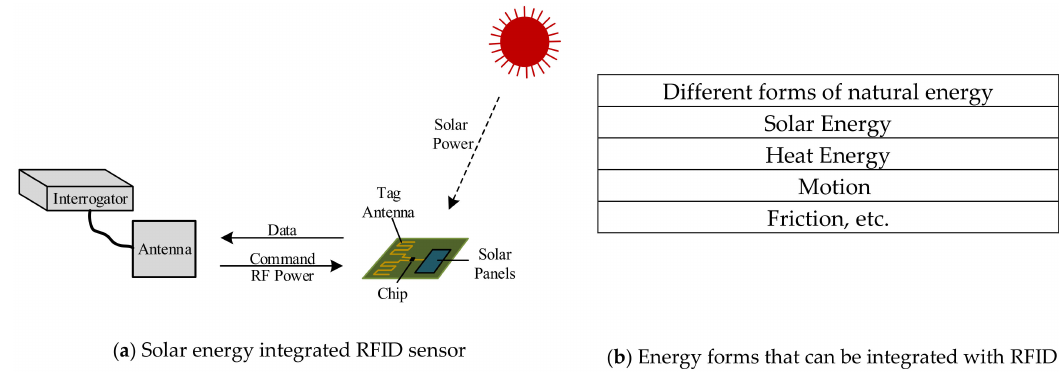
Figure 6. RFID sensor with multi-port energy